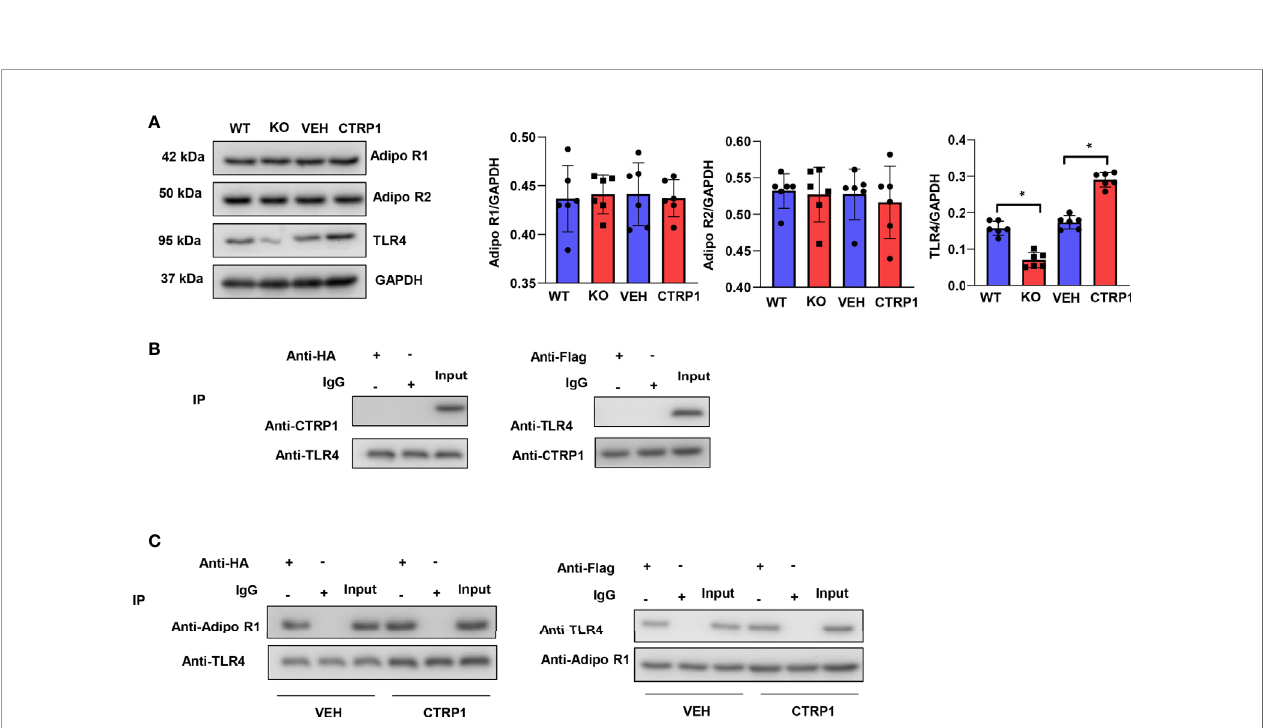
FIGURE 8 | CTRP1 increases the interaction between adiponectin receptor 1 and TLR4. (A) The expression levels of Adipo R1, Adipo R2 and TLR4 in bone marrow-derived macrophages isolated from CTRP1 -/- mice as well as WT mice treated with CTRP1 in vitro . (B) Bone marrow-derived macrophages were cotransfected with psicoR-HA-TLR4 and psicoRFlag-CTRP1, and a coimmunoprecipitation experiment was performed. (C) Bone marrow-derived macrophages were cotransfected with psicoR-HA-TLR4 and psicoRFlag-Adipo R1, and a coimmunoprecipitation experiment was performed. * P <0.05. All in vitro experiments were repeated 3